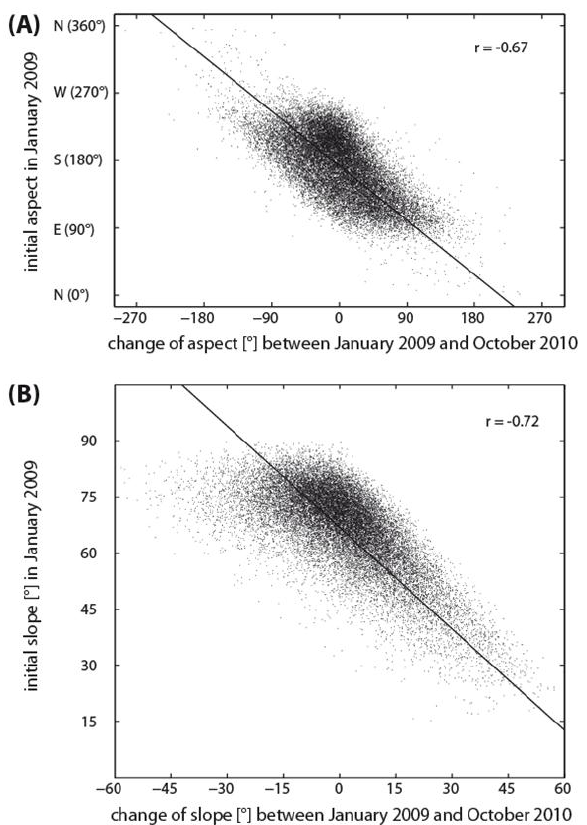
Figure 5: The tendency of the ice cliff to form and to maintain an “ideal orientation”, which is assumed to be near-vertical and